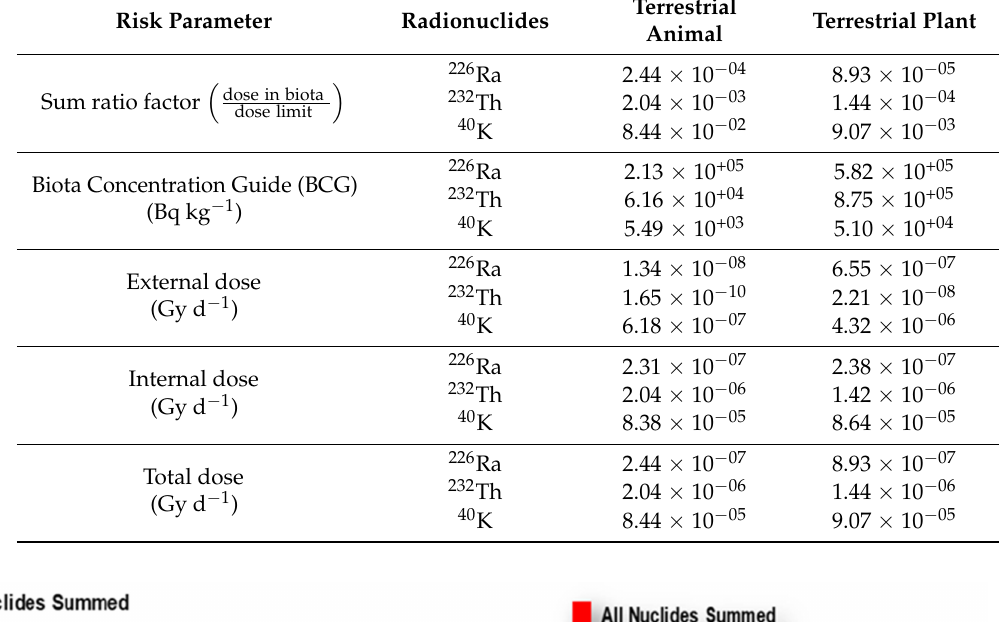
Terrestrial Terrestrial Plant Animal